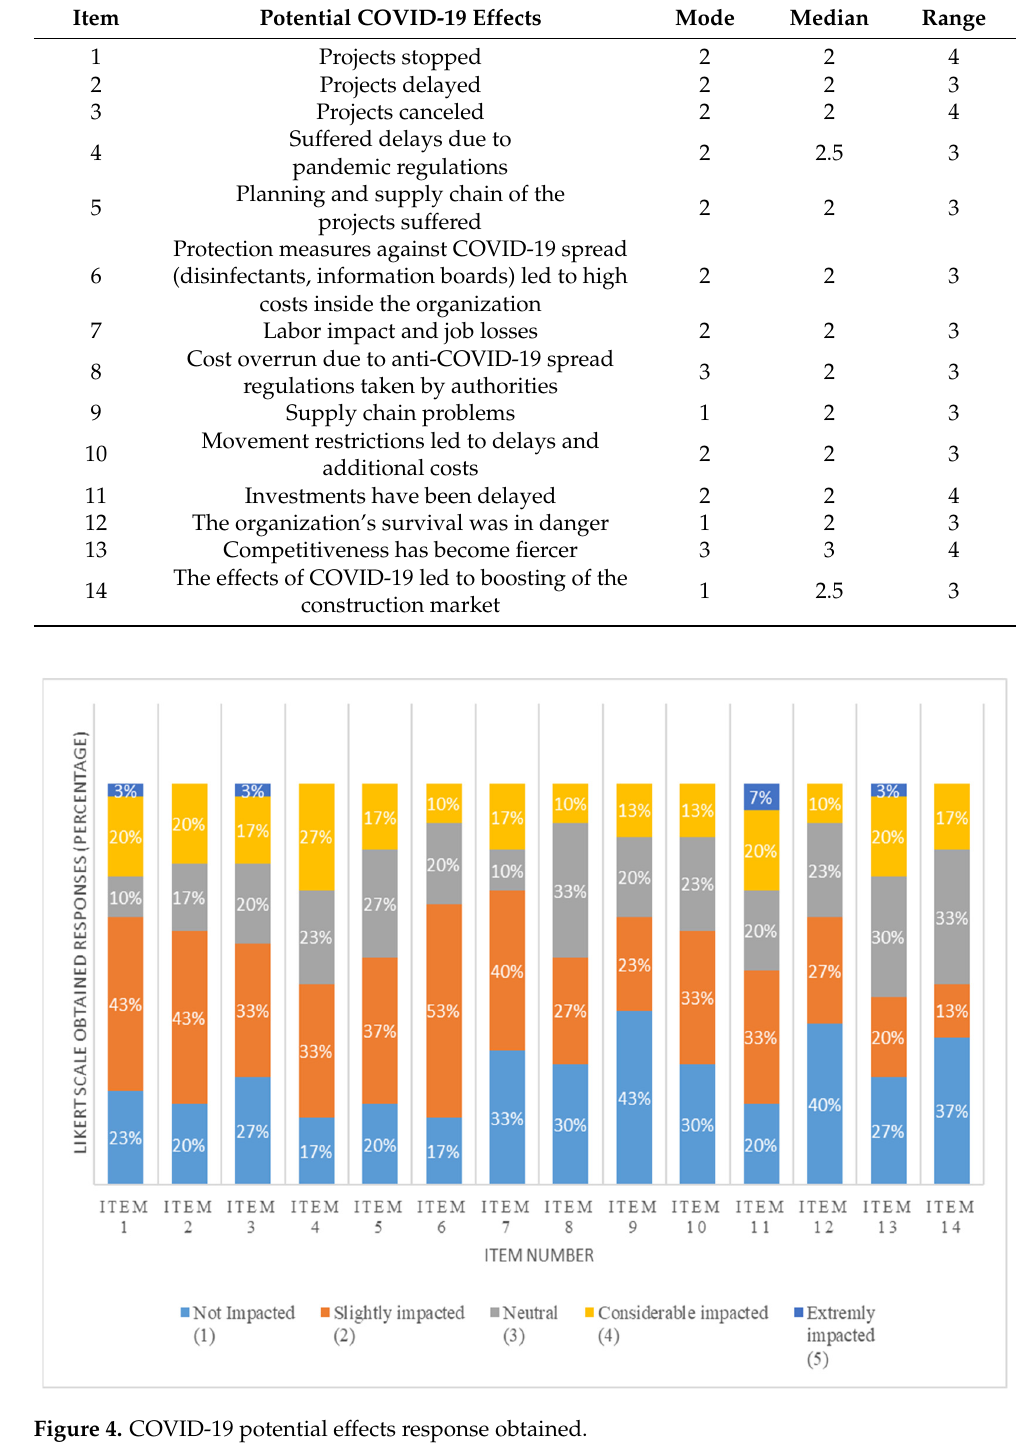
Table 3. Responses obtained for the section potential COVID-19 effects.